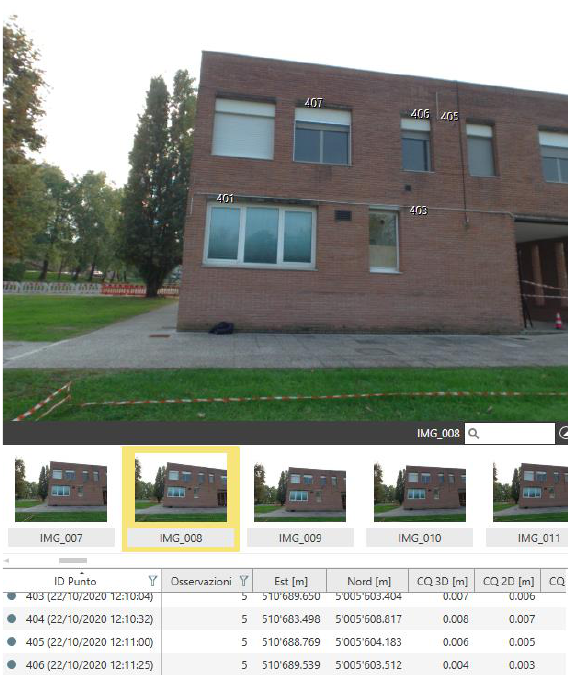
Figure 4. Detail of the interface of the Leica Infinity software by which point measurements were performed in the office.